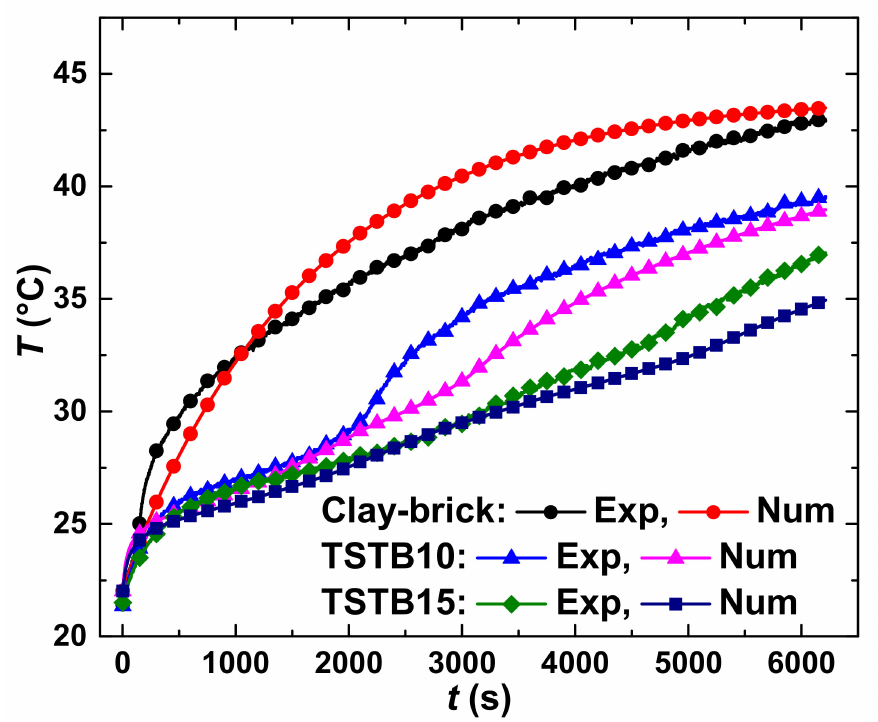
Figure 8. Numerical (Num) results and their validation via experimental (Exp)